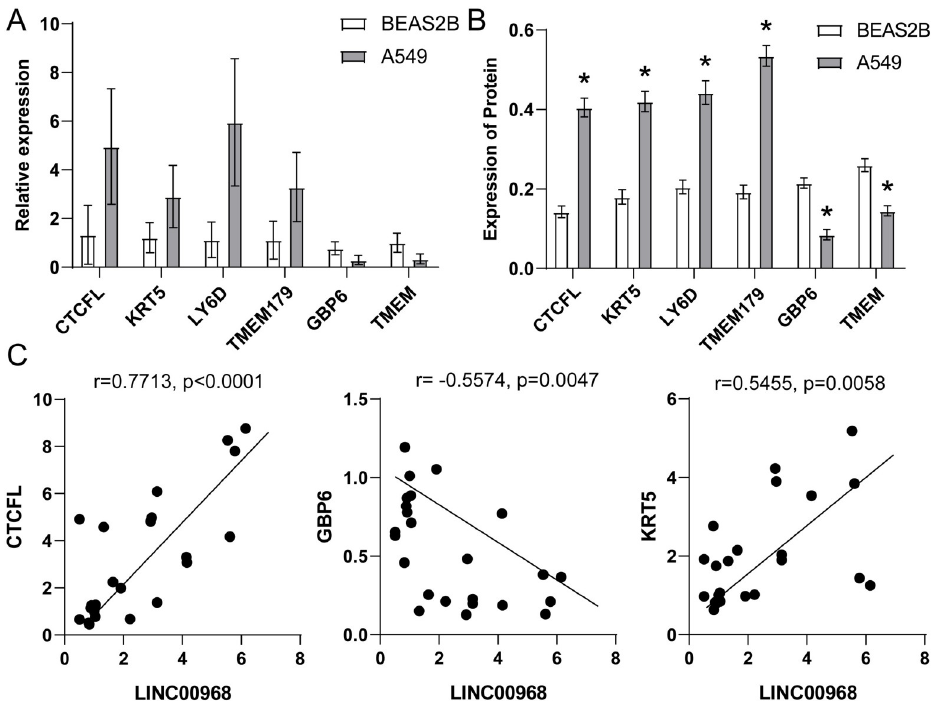
Fig 11. Verification of mRNA differentially expressed in BEAS2B and A549. qRT-PCR (A) and WB (B) were used to detect the expression levels of CTCFL, KRT5, LY6D, TMEM, GBP6, TMEM179. (C) Pearson analysis was used to detect the correlation between LINC00968 and CTCFL, GBP6, KRT5.